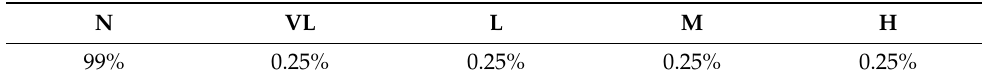
Table 2. Prior probability distribution P ( Y ) for BV leakage.